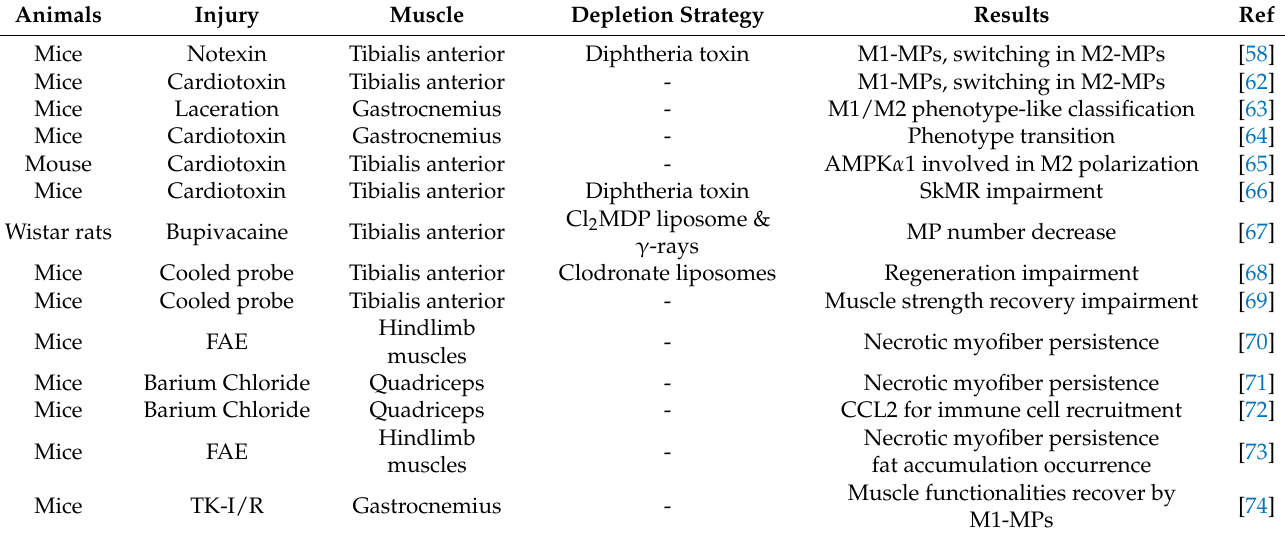
Table 2. Macrophages and skeletal muscle regeneration. In vivo